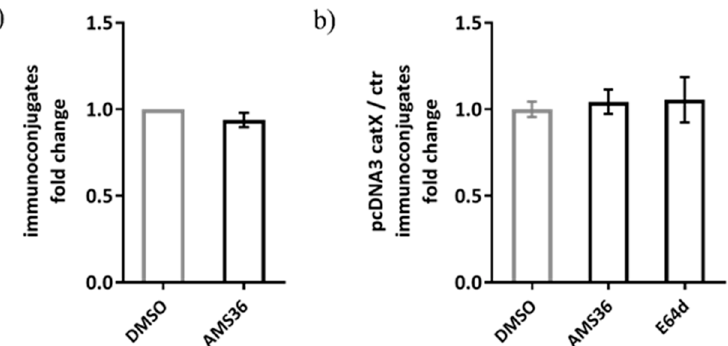
Figure 8. The relative comparison of SEE-specific immunoconjugate formation between DMSO or AMS36 treated-Jurkat cells with Raji cells. The proportion of immunoconjugates was determined by performing flow cytometry and gating the doublets positive for CMAC-labelled Jurkat and CMTMR-labelled Raji cells in FlowJo software. The relative comparison between vehicle and inhibitor-treated cells was made for wild type Jurkat cells ( a ) and for cathepsin X-overexpressing Jurkat cells ( b ). The results represent the mean ± SD of the three independent experiments.